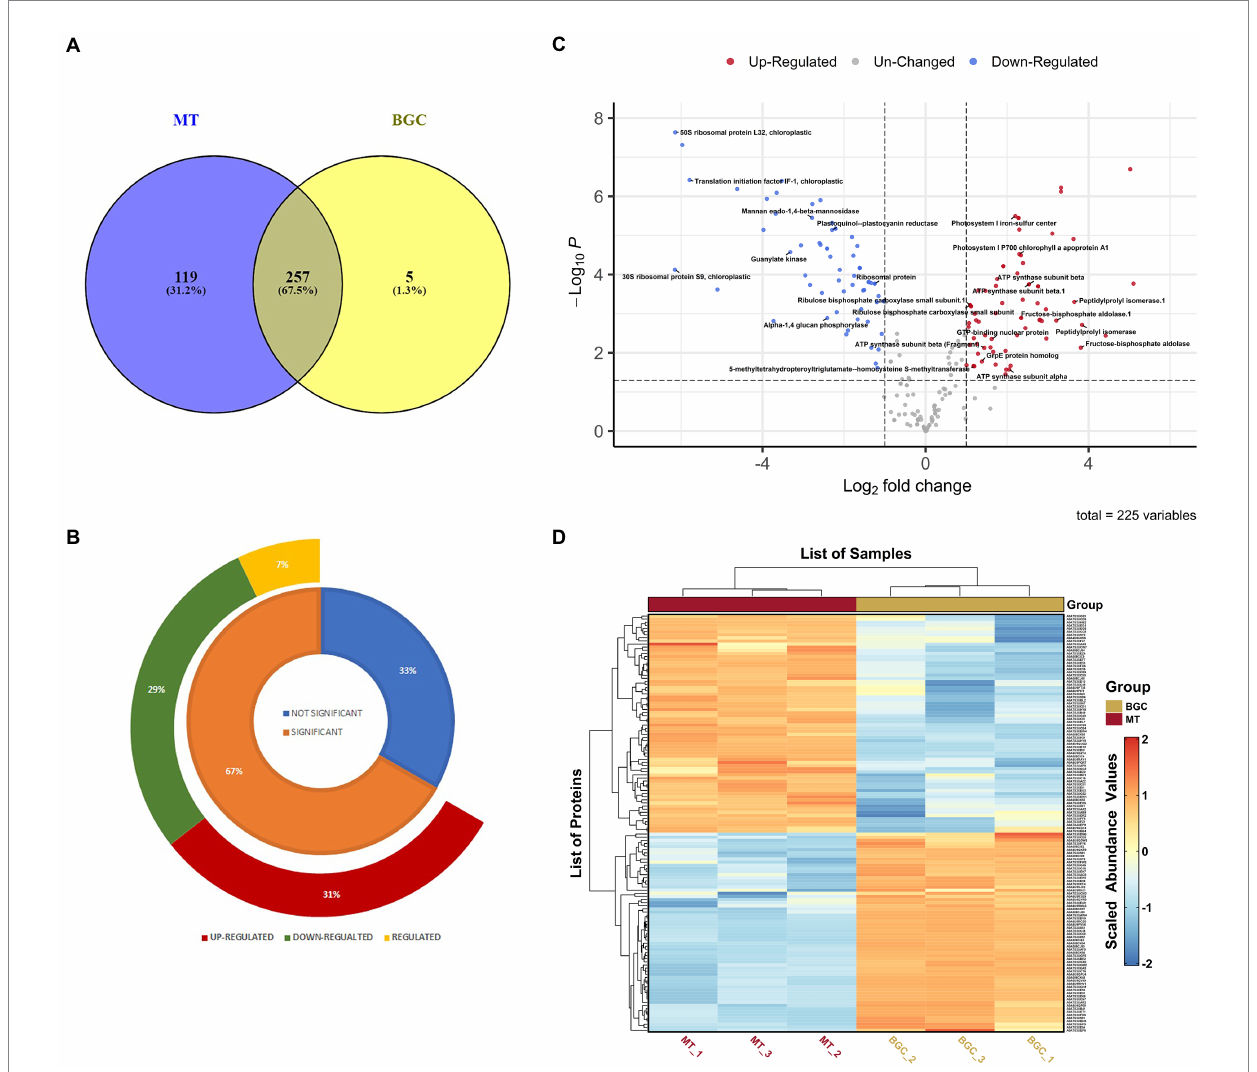
FIGURE 1 Differentially abundant proteins (DAPs) in elevated Ci and salt in Picocystis salinarum SLJS6. (A) Venn diagram of BG11 (BGC) and M (MT) specific proteins with overlapping regions indicating the number of common proteins. (B) doughnut chart highlighting the T-test results (the regulated proteins are those significantly altered proteins whose log2 Fold Change value fell between the cutoff values i.e., > − 1 and <1). (C) Volcano plot of the proteins quantified during LFQ analysis comparing control (BGC) to treatment (MT). Each point represents the difference in expression (fold-change) between the two groups plotted against the level of statistical significance. (D) Heatmap depicting DAPs comparing control (BGC) to treatment (MT)